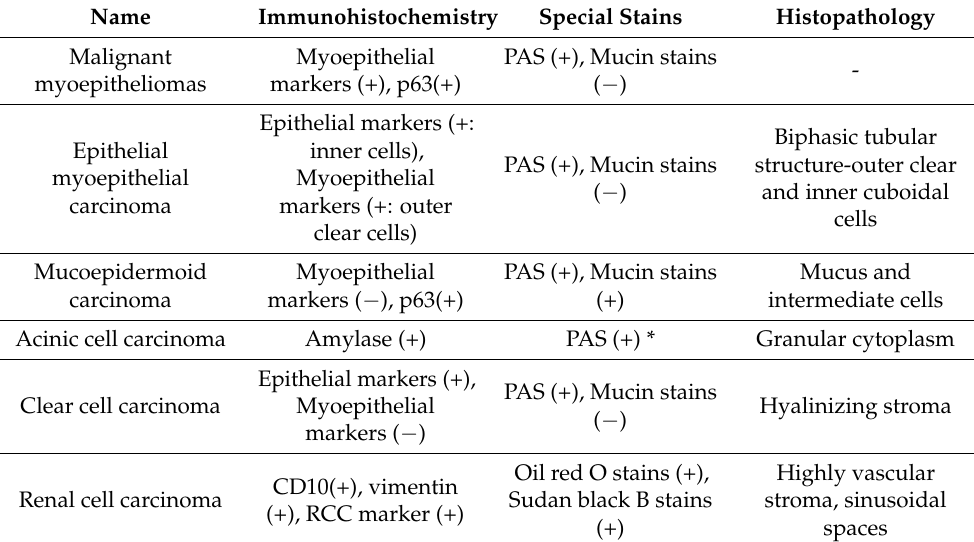
Table 1. Diagnostic immunohistochemical markers, special stains, and histopathological features for clear cell